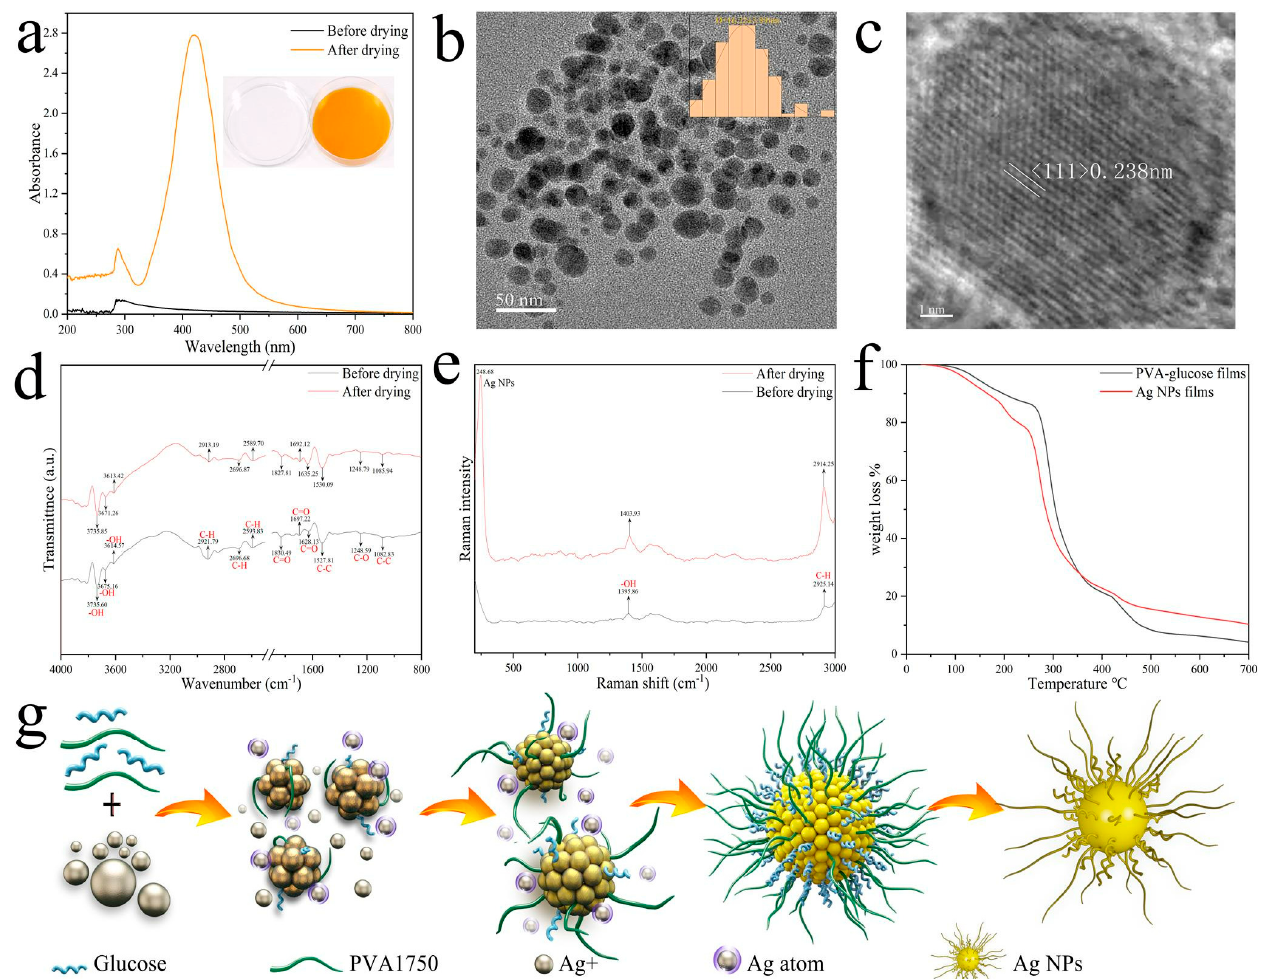
Figure 1. ( a ) Digital photographs of colorless and transparent mixed solution before drying and yellow Ag NP films after drying, and the corresponding UV − visible spectra were recorded; ( b ) particle size and TEM image of Ag NPs; ( c ) HRTEM image of Ag NPs; FTIR ( d ) and Raman ( e ) spectra of colorless and transparent mixed solution before drying and yellow Ag NP films after drying; ( f ) TGA analysis of PVA − glucose films and Ag NP films; ( g ) A mechanism for nanoparticle formation of Ag NPs.